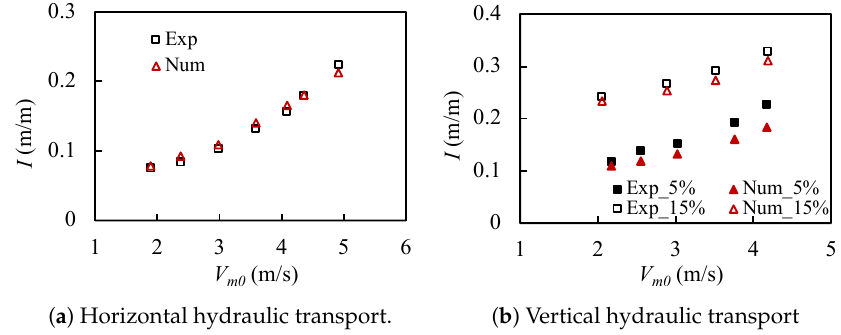
Figure 6. Comparison between numerical results and published experimental data